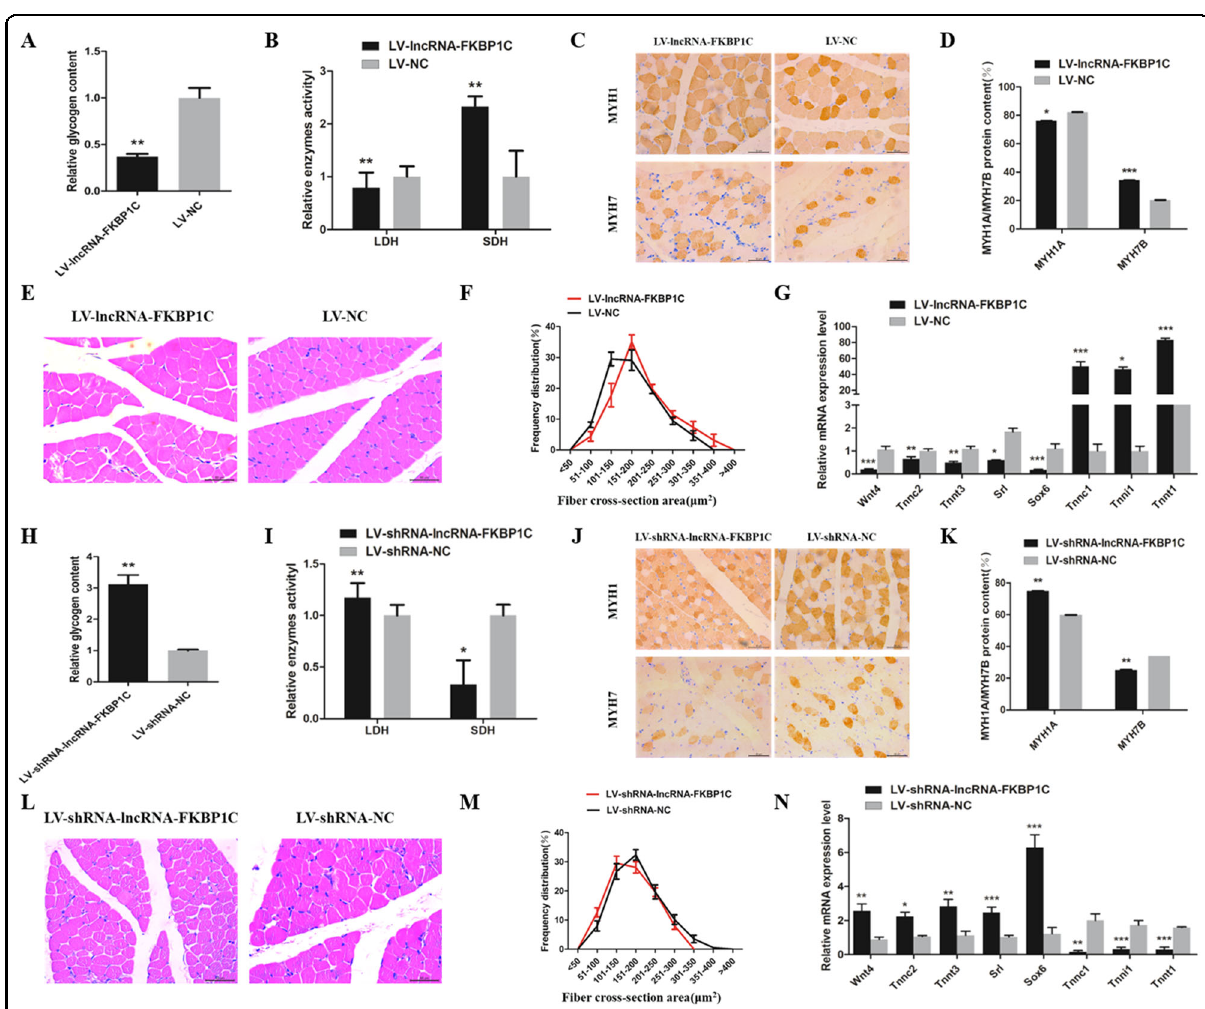
Fig. 7 LncRNA-FKBP1C regulates muscle hypertrophy and conversion of muscle fi ber types. A The glycogen content after lncRNA-FKBP1C overexpression prepared with lentivirus and intramuscularly injected into the gastrocnemius muscle. B The enzyme activity of LDH and SDH. C Immunohistochemistry analyses of gastrocnemius muscle fi ber infected with LV-lncRNA-FKBP1C or LV-NC. D The data are showed as MYH1A and MYH7B protein content. E Hematoxylin and eosin (H&E) staining of gastrocnemius muscle. F The distribution of muscle fi ber cross sectional area ( n = 6 per group). G The mRNA level of several fast muscle genes and slow muscle genes. H The glycogen content after infected with LV-shRNA-lncRNA- FKBP1C or LV-shRNA-NC. I The enzyme activity of LDH and SDH. J Immunohistochemistry analyses of gastrocnemius muscle fi ber. K The MYH1A and MYH7B protein content. L Hematoxylin and eosin (H&E) staining of gastrocnemius muscle. M The distribution of muscle fi ber cross sectional area ( n = 6 per group). N The mRNA level of several fast muscle genes and slow muscle genes. Results are shown as mean ± S.E.M. and the data